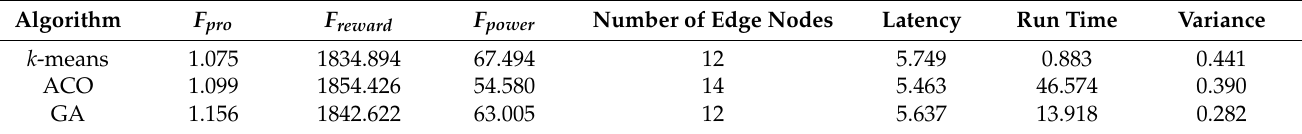
Table 4. Comparison of three